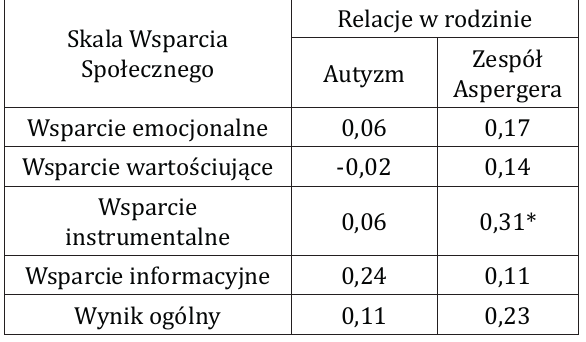
Correlation between the assessment of family relations and psychological factors in mothers of children diagnosed... 279 Tabela 4. Współczynniki korelacji obliczone między oceną relacji w Tabela 6. Współczynniki korelacji obliczone między oceną relacji rodzinie a stylami radzenia sobie ze stresem (CISS) w grupie matek w rodzinie a Skalą Wsparcia Społecznego w grupie matek dzieci z dzieci z autyzmem i zespołem Aspergera